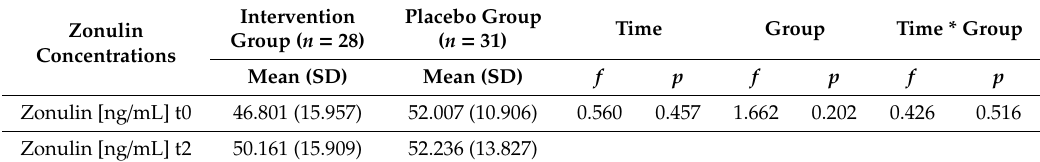
Table 3. Changes in Zonulin